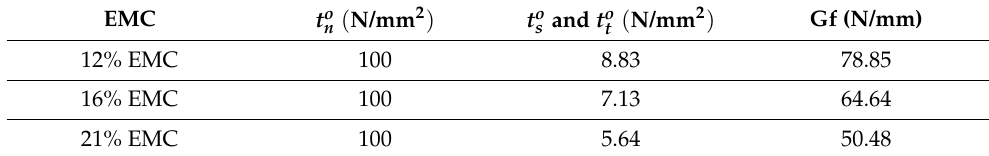
Table 18. 130 × 260 mm Glulam damage initiation and evolution